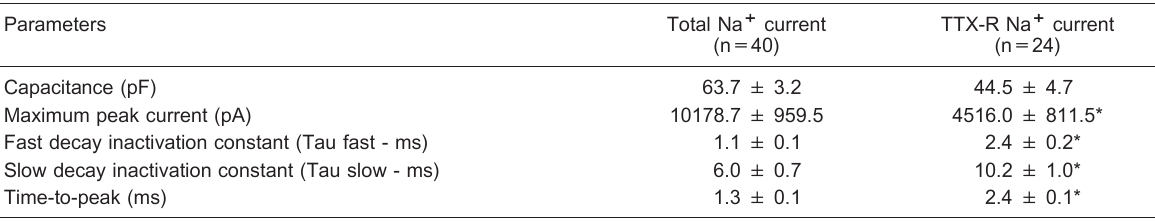
Table 2. Kinetic parameters of total and TTX-R Na + current of dorsal root ganglion neurons. Parameters